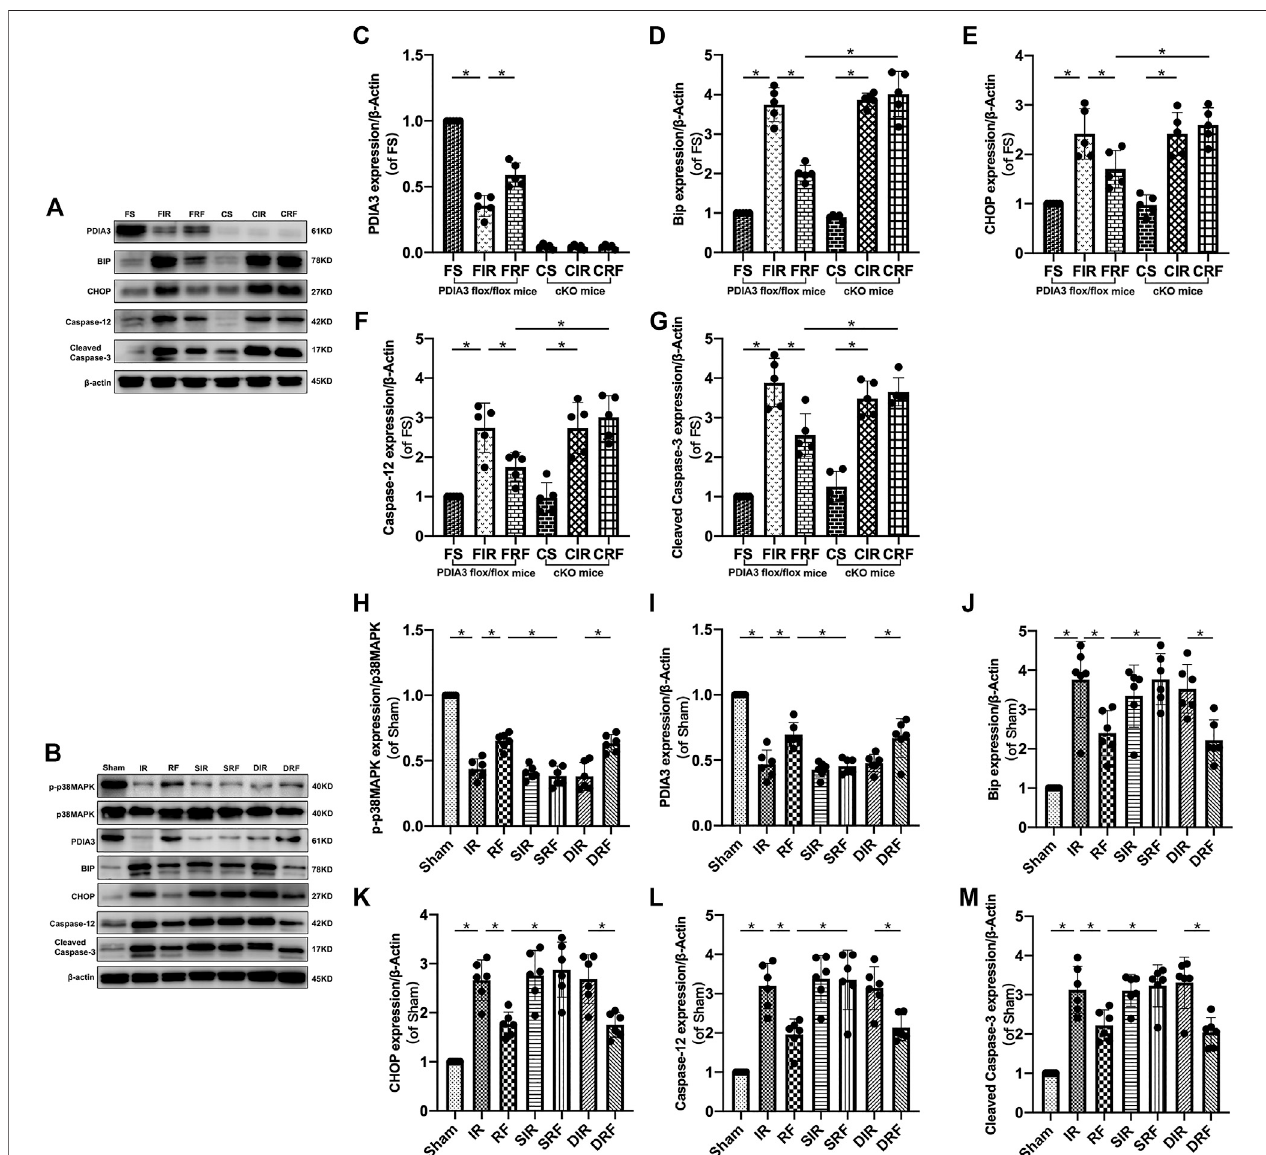
FIGURE 5 | Changes in relevant intestinal protein expression. Groups are the same as in Figure 1 . Representative Western blot bands (A,B) show p-p38MAPK, p38MAPK, PDIA3, Bip, CHOP, caspase-12, cleaved caspase-3 and β -actin expression in the intestinal mucosa. Quantitative changes in protein concentrations (C – M) are shown by densitometry analysis from the Western blotting assay ( n = 5 – 6). Data are expressed as mean ± SD. The results were compared by ANOVA with Tukey ’ s post hoc test. * P < .05.